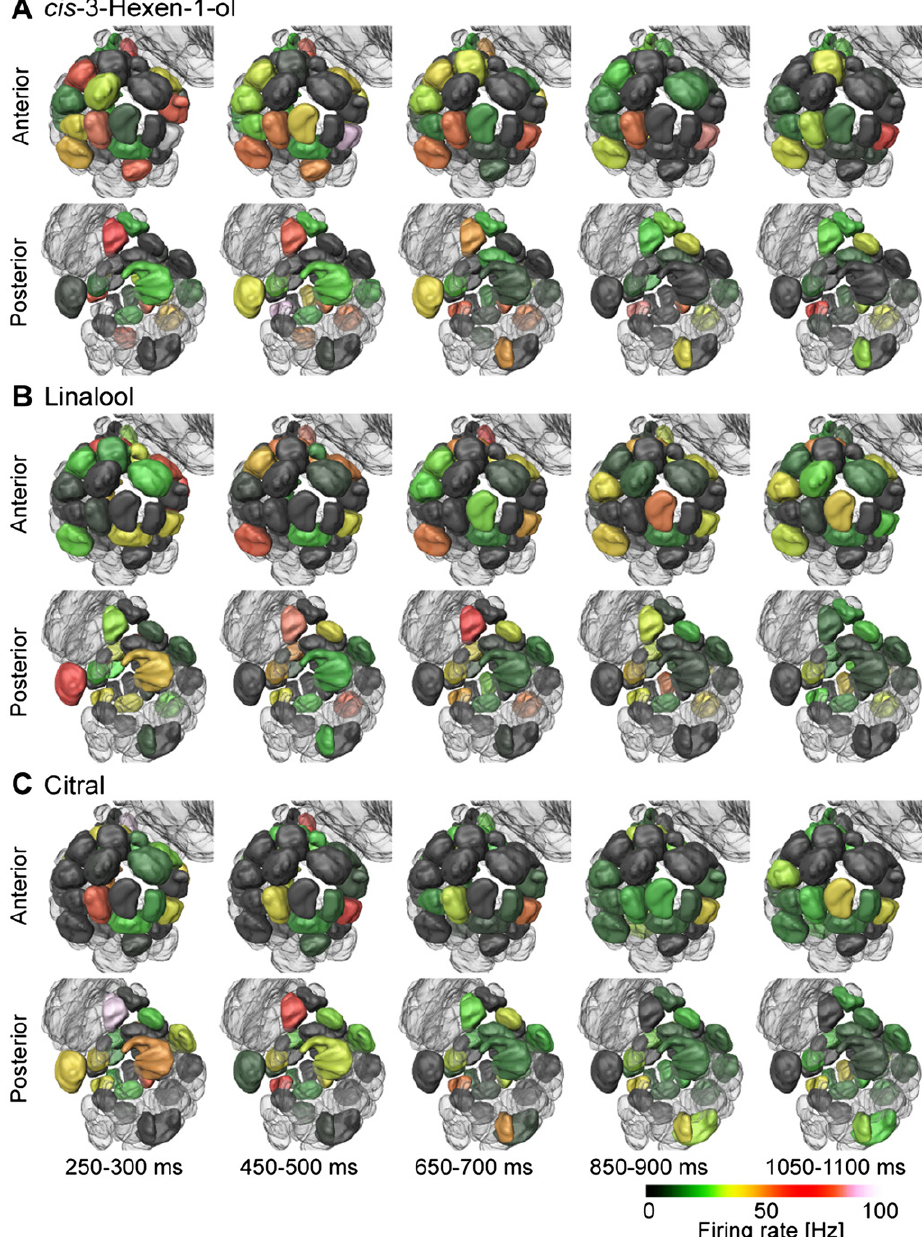
Figure 4 | Reconstructed geometry of odor-evoked fi ring activity . Anterior and posterior views of reconstructed population activities in response to cis - 3-hexen-1-ol (A) , linalool (B) , and citral (C) . The color within each glomerulus represents the average fi ring rate from baseline of the innervating PNs. The glomeruli that we did not record are transparent in color. Responses at 250–300, 450–500, 650–700, 850–900, and 1050–1100 ms after stimulus onset are shown in the same